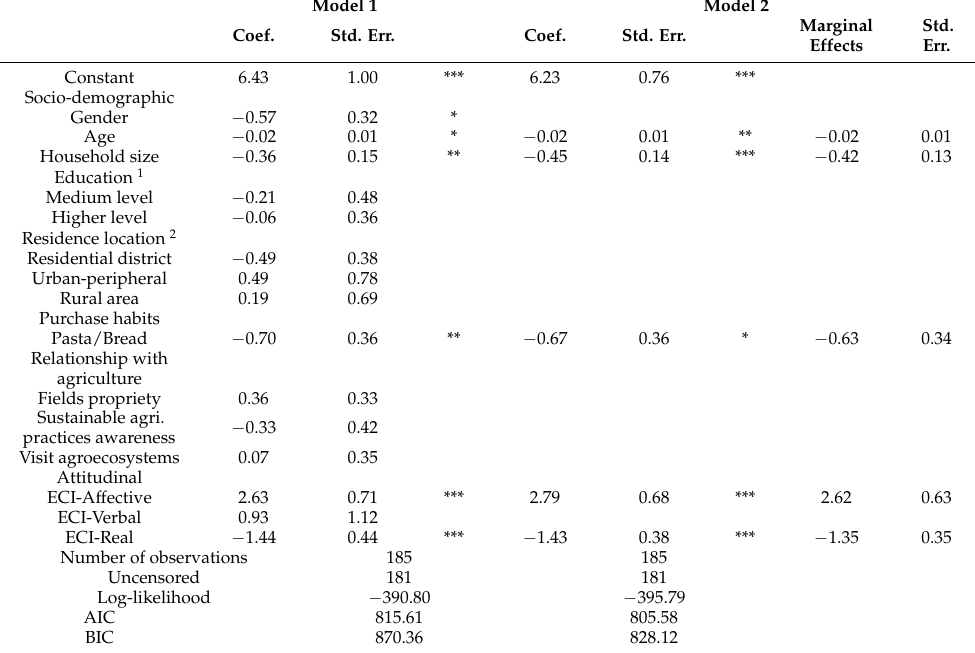
Table 3. WTP function. Results from the Tobit models.